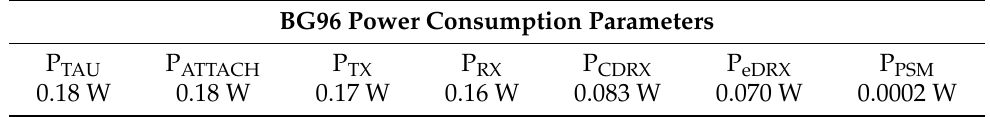
Table 6. Power consumption parameters of the BG96